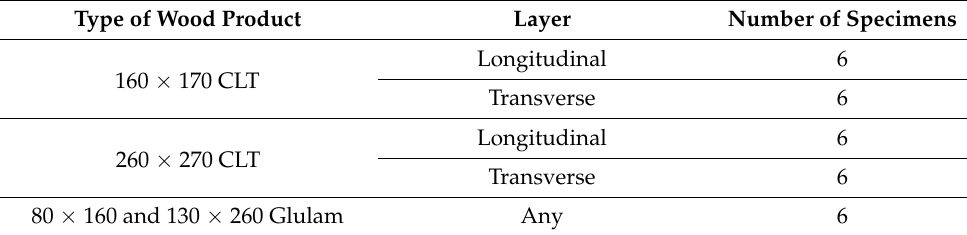
Table 3. Specimens included in each sample